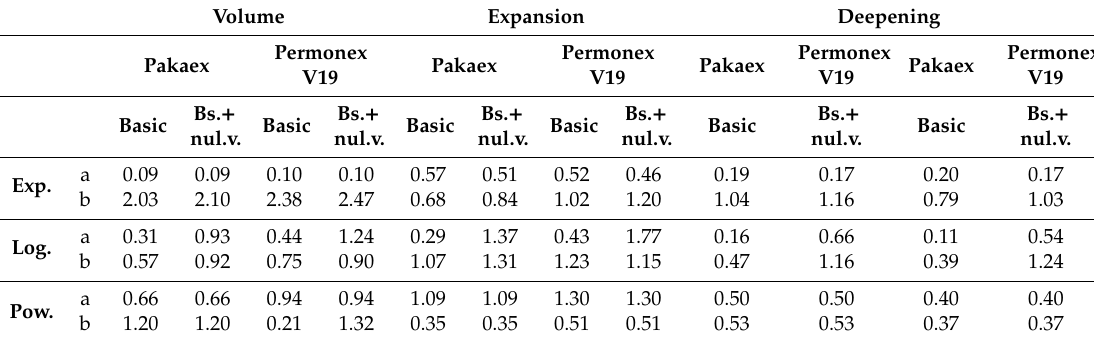
Table 3. Model parameters values.